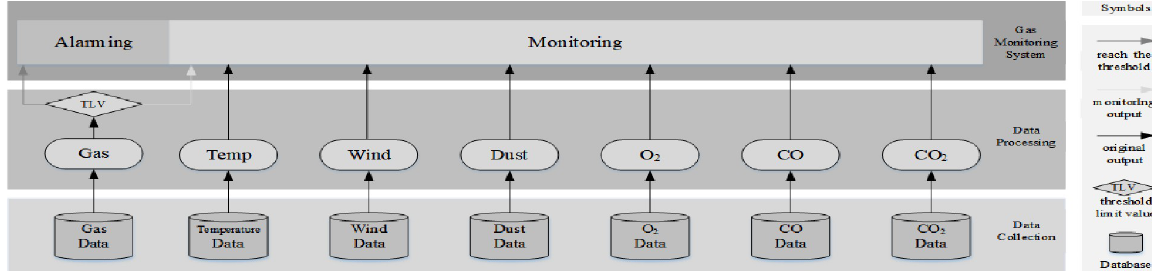
Fig 1. Current gas monitoring system in the case study mine. (Wu et al. 2021, p.3180) [46].